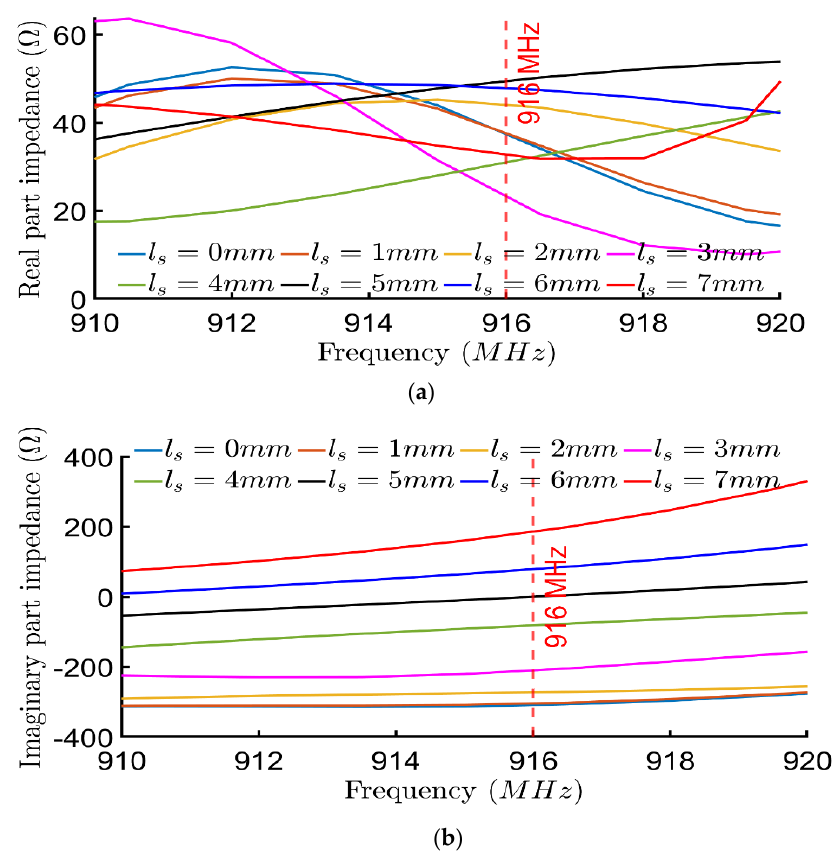
Figure 12. The proposed structure impedance vs. different stubs’ length ls : ( a ) The real part of the impedance; ( b ) The imaginary part of the impedance.